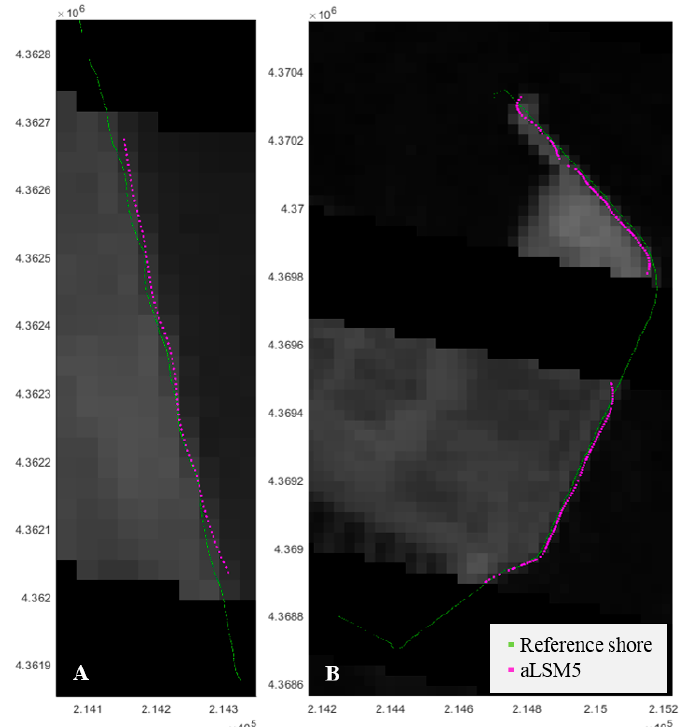
Figure 8. Local examples of the sub-pixel shoreline solution for 14 September 2016 following the aLSM5 method in both study areas: El Saler beach ( A ) and the port of Valencia ( B ). The shoreline solution is mapped above its corresponding L7 image (SWIR1 band) and compared with the true shoreline used as reference, as measured by GPS when the satellite passed overhead in (A) and digitalized over a high-resolution orthophoto in (B). The grid coordinates are: GCS_ETRS89 UTM31N. Results in the beach area indicate that although shorelines are biased seaward, the use of an adaptive window significantly reduces this trend and the shoreline is defined with a mean horizontal error (µ ± σ ) of 4.50 ± 7.6 m and 5.98 ± 5.53 m by adjusting respectively a third (aLSM3) or fifth-degree (aLSM5) polynomial. In the port area, the RMSEs are generally worse because the standard deviations are greater and show a very heterogeneous error distribution that causes a flattening of their histogram. This fact responds to the greater radiometric variation found in the terrestrial part of the port area than in the sandy beach site where the numbers remain more homogeneous—as anticipated by [33]. Moreover, many negative errors indicate a slight landward bias of the shoreline and affect the average error by reducing it to values near zero. The freedom to work with adaptive windows ensure that these recreate the location with the maximum radiometric variations. Consequently, the search for the sub-pixel shoreline position will be made in the optimal neighbourhood, improving the accuracy of the results. However, the second challenge of the proposed methodology is analysed in next section. 5.2. Benefits of the Complete Solution through the Lagrange Interpolator Polynomial Working with the discussed adaptive window, this section evaluates the solvency of the complete sub-pixel shoreline solution (aLgr)—performed with the Lagrange interpolator polynomial as described Section 3.2—by comparing against the least squares solution (aLSM). The mathematical difference between both is based on the fact that least squares uses the window with the DNs previously upsampled in a refined mesh whereas Lagrange uses the raw values to carry out the adjustment. Therefore, Lagrange polynomial coincides in the centre of each pixel with the real DN of the image while LSM computes the polynomial that passes closest to the interpolated values.